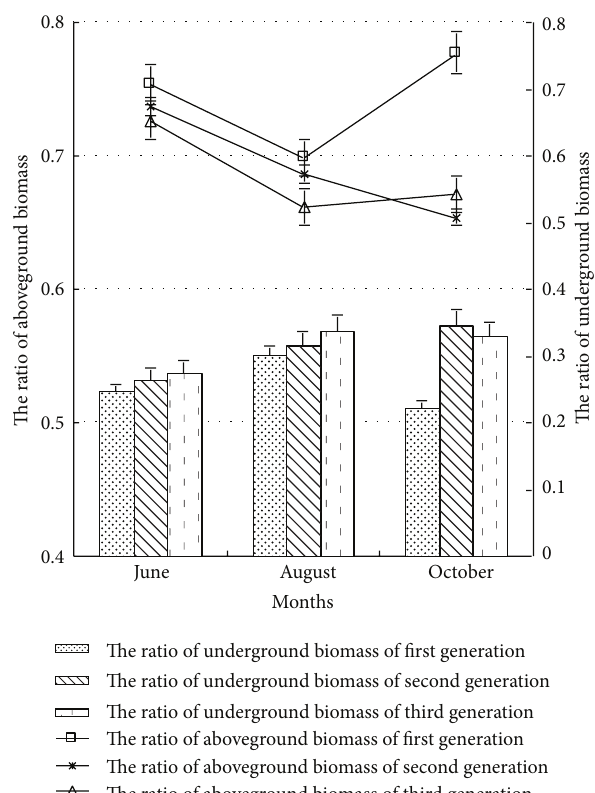
Figure 4: The ratio of aboveground and underground biomass of poplar under different continuous